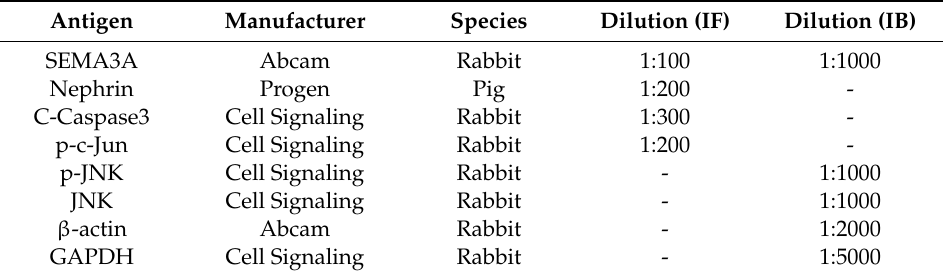
Rabbit Abcam Rabbit - 1:2000 GAPDH Cell Signaling Rabbit